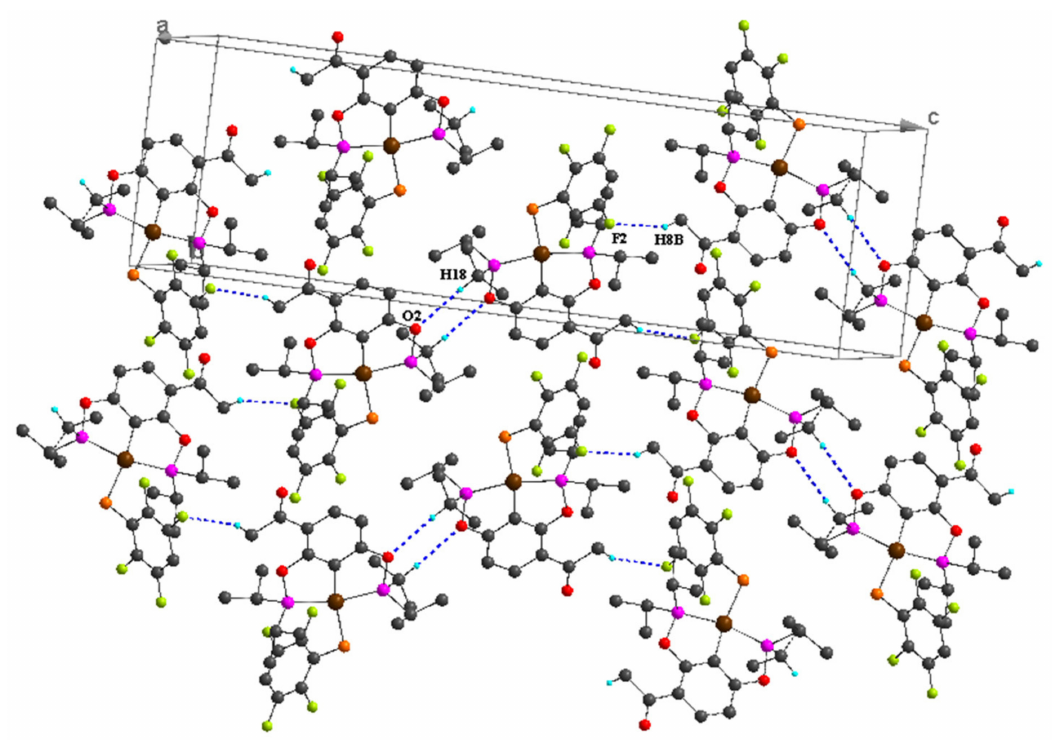
Figure 6. Fragment of the molecular packing showing the C18–H18 ··· O2 and C8–H8B ··· F2 interac- tions (dashed lines) forming a layer arrangement parallel to the (101) plane, H atoms not involved in these interactions have been omitted for